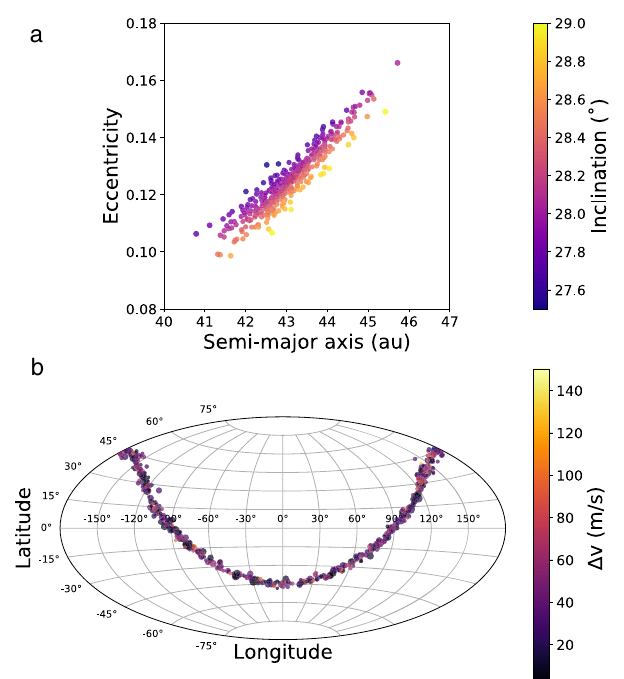
Fig. 1 A synthetic planar family. A realization of a graze-and-merge (planar) Haumea family. In panel a , the family is shown in a-e-i space. The family shape and distribution are typical for a graze-and-merge collision, with the planar distribution of family members visible as a distinct correlation between semi-major axis, eccentricity, and inclination. In panel b , the ejection direction of each family member is shown in ecliptic latitude and longitude. Here the size of each family member corresponds to the size of the point. This demonstrates that the family members are ejected in a planar manner, with a typical planar dispersion of ~2°, consistent with the properties of a graze-and-merge family. Source data for this fi gure are provided as a Source data fi